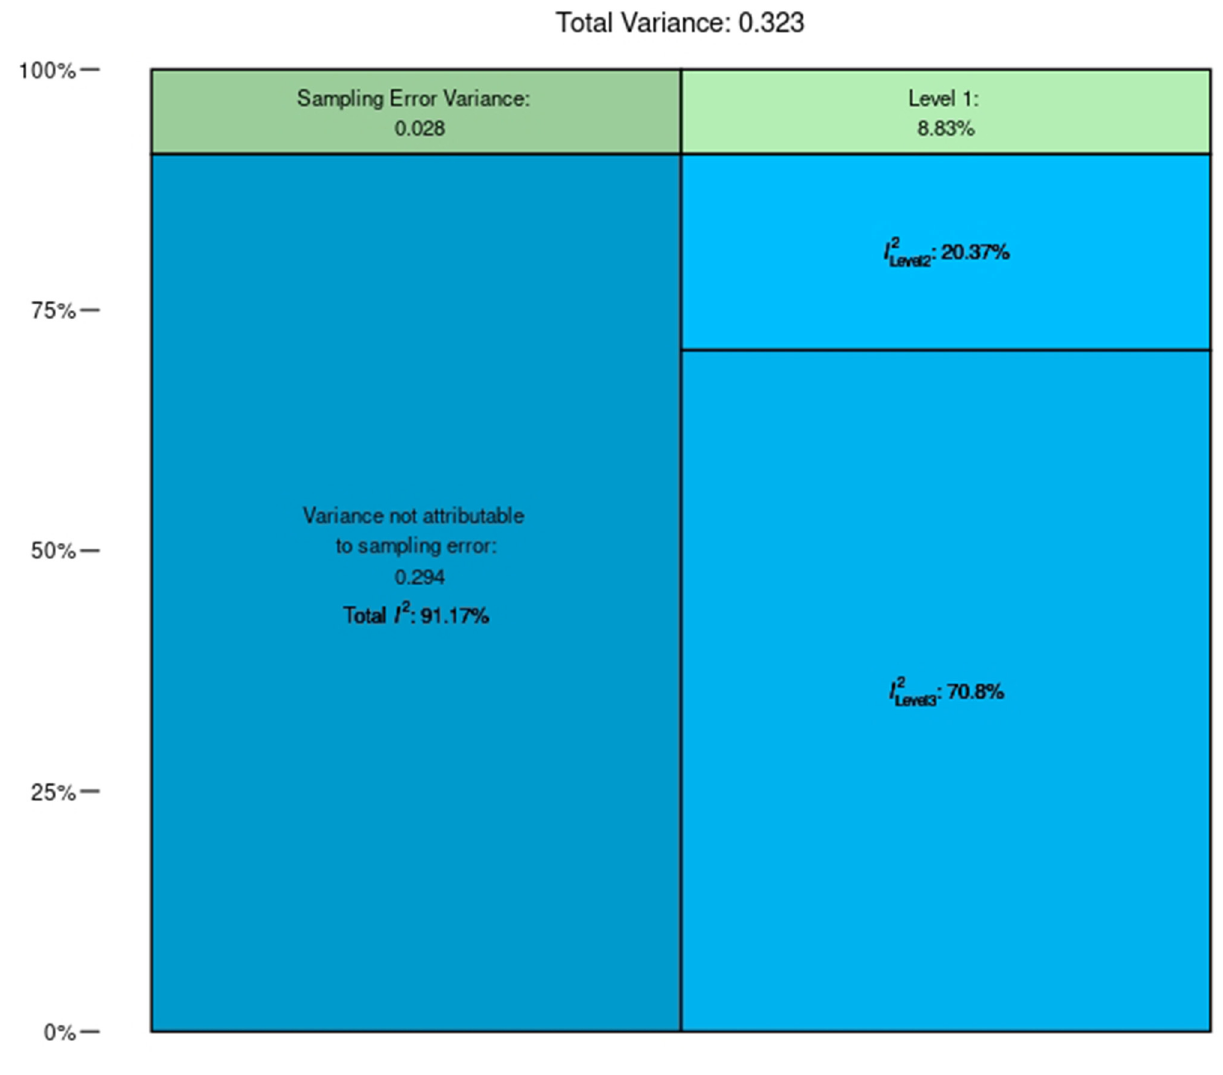
FIGURE 6 | Meta-correlation (Model 1) variance breakdown by level. The majority of heterogeneity within this model results from Level